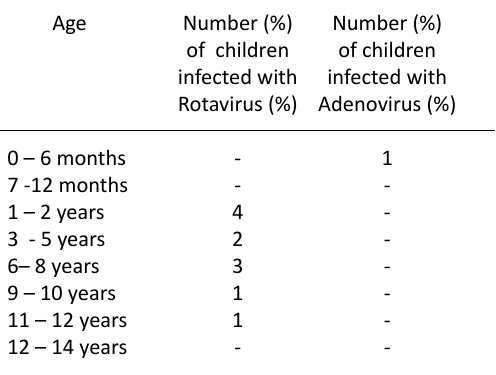
table 3. Age distribution of children infected with Rotavirus / Adenovirus